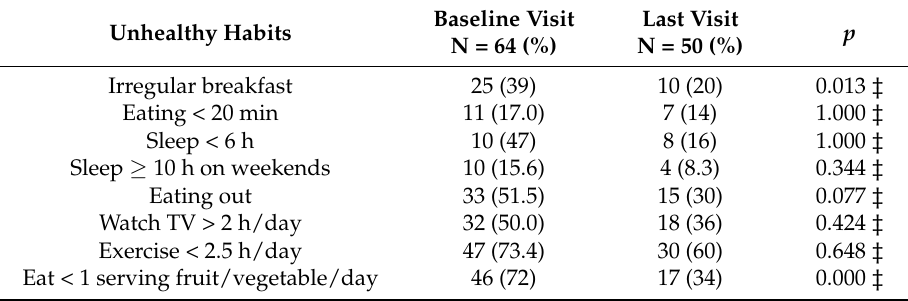
Table 4. Unhealthy habits of parents in baseline and last